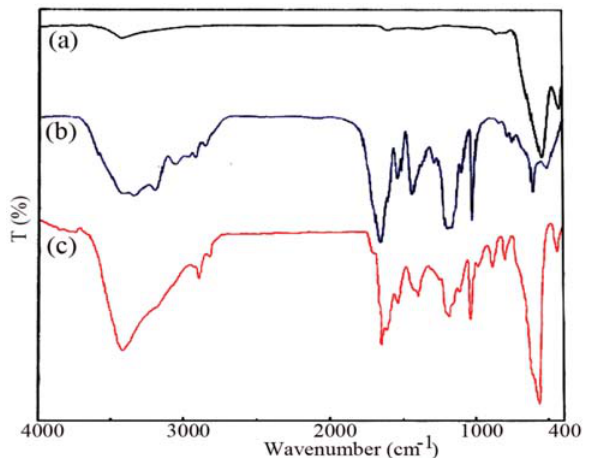
Figure 2. TGA curves of Fe